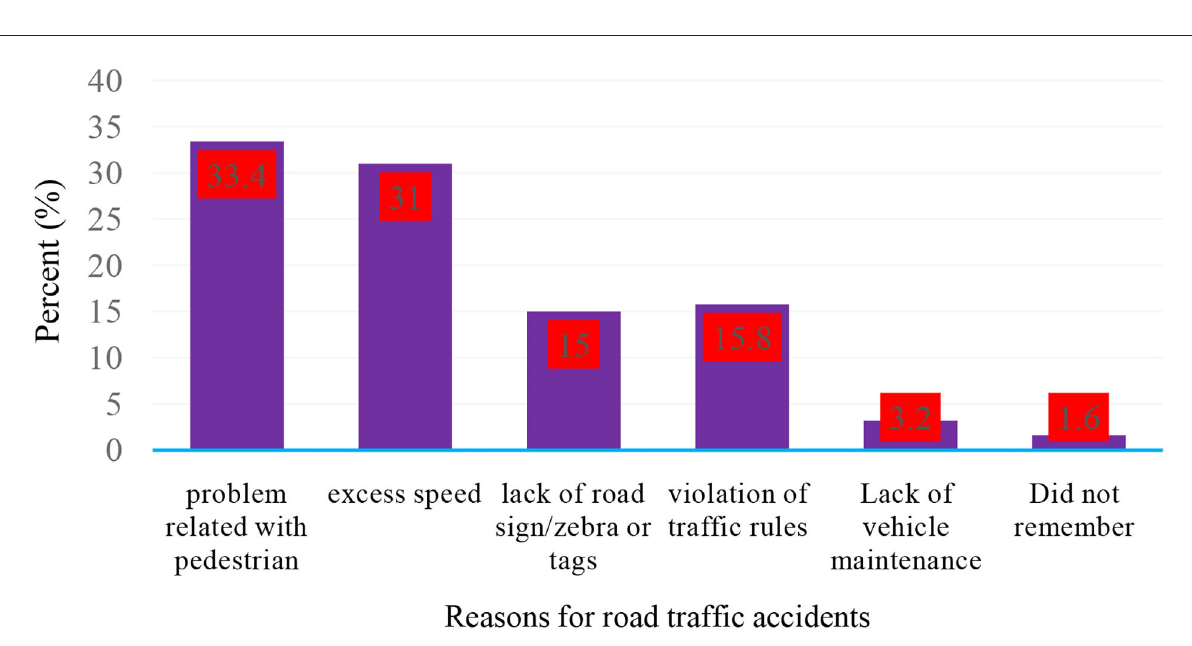
The prevalence rate found by this study was also higher than that in a study conducted in Brazil, where the prevalence of road traffic accidents among motorcyclists in the previous 12 months